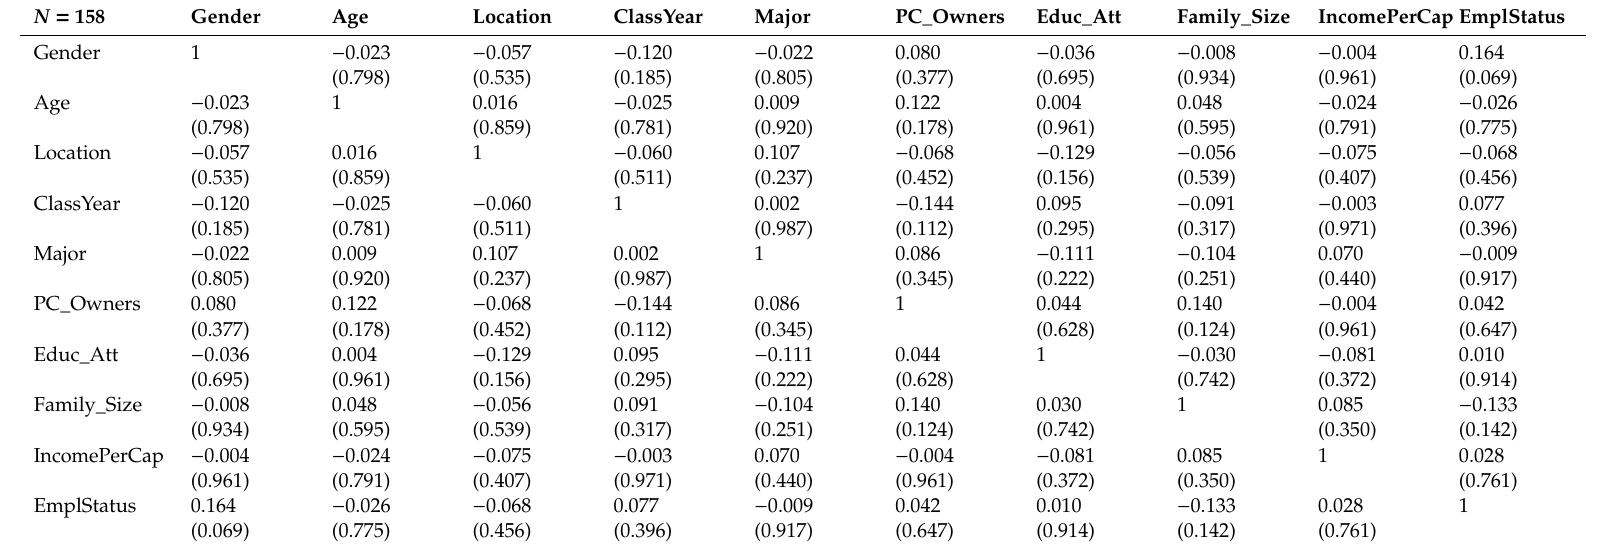
Table 6. Correlation between variables characteristics of Matrix M and W for the 4th